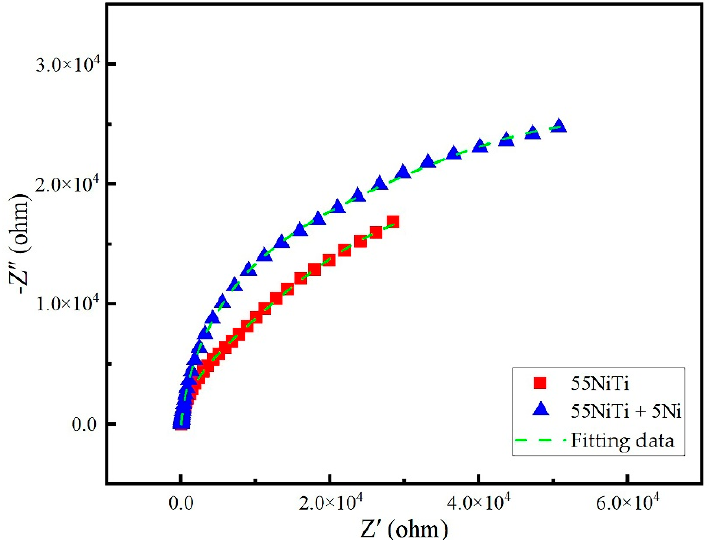
Figure 13. Nyquist plots from the electrochemical impedance spectroscopy (EIS) results of the coatings.